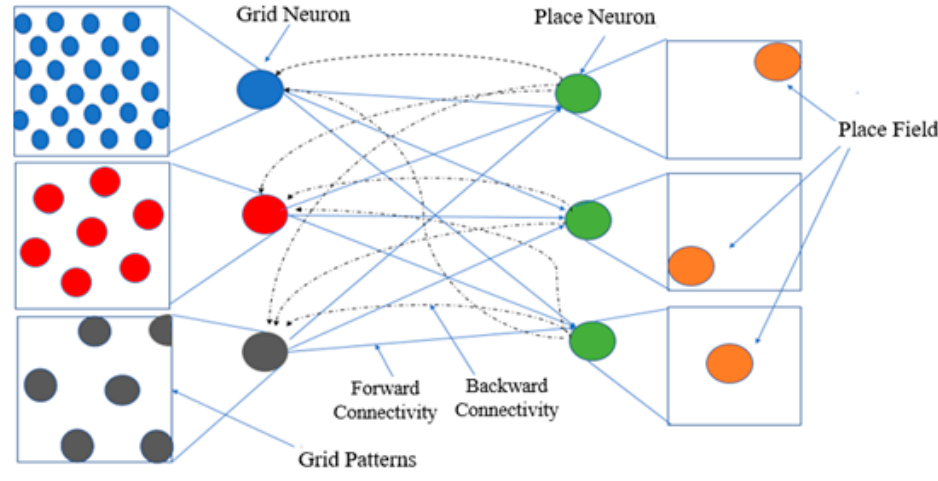
Figure 3. The connectivity of place and grid neuron.